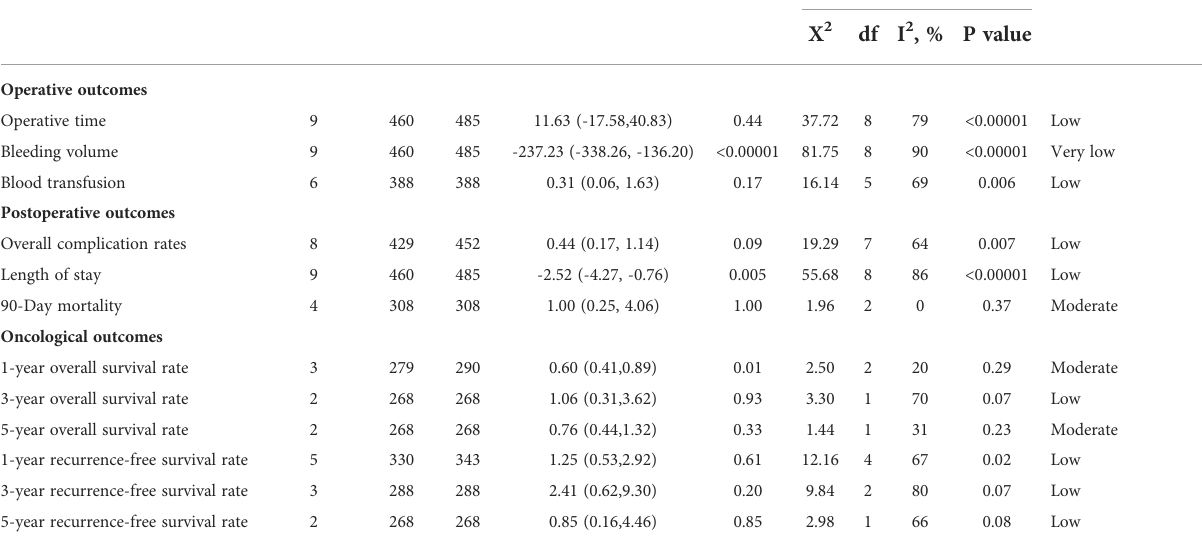
TABLE 2 Summary results of the